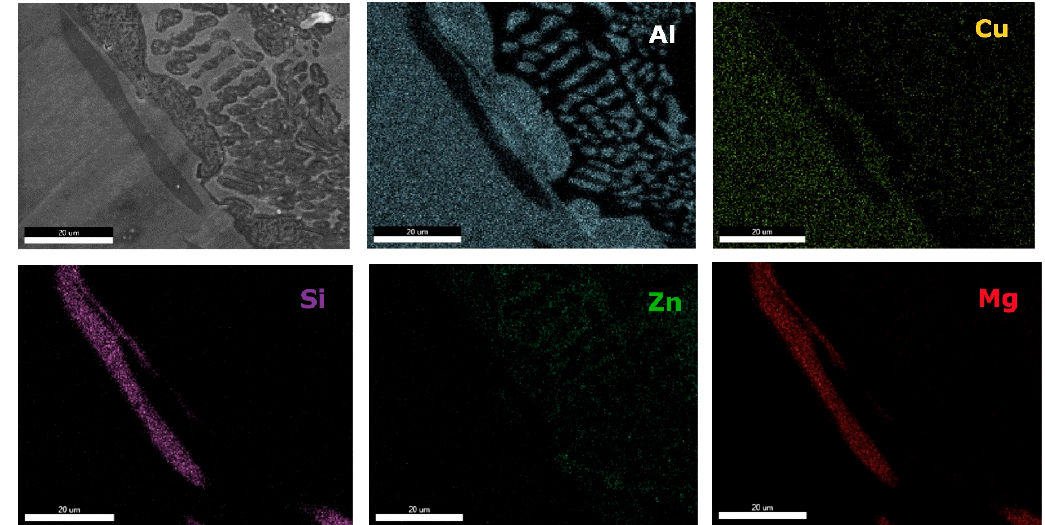
Figure 16. EDS mapping of as-cast Al 3.4 Cu 0.5 Si 0.2 Zn 0.5 Mg 0.2 alloy.